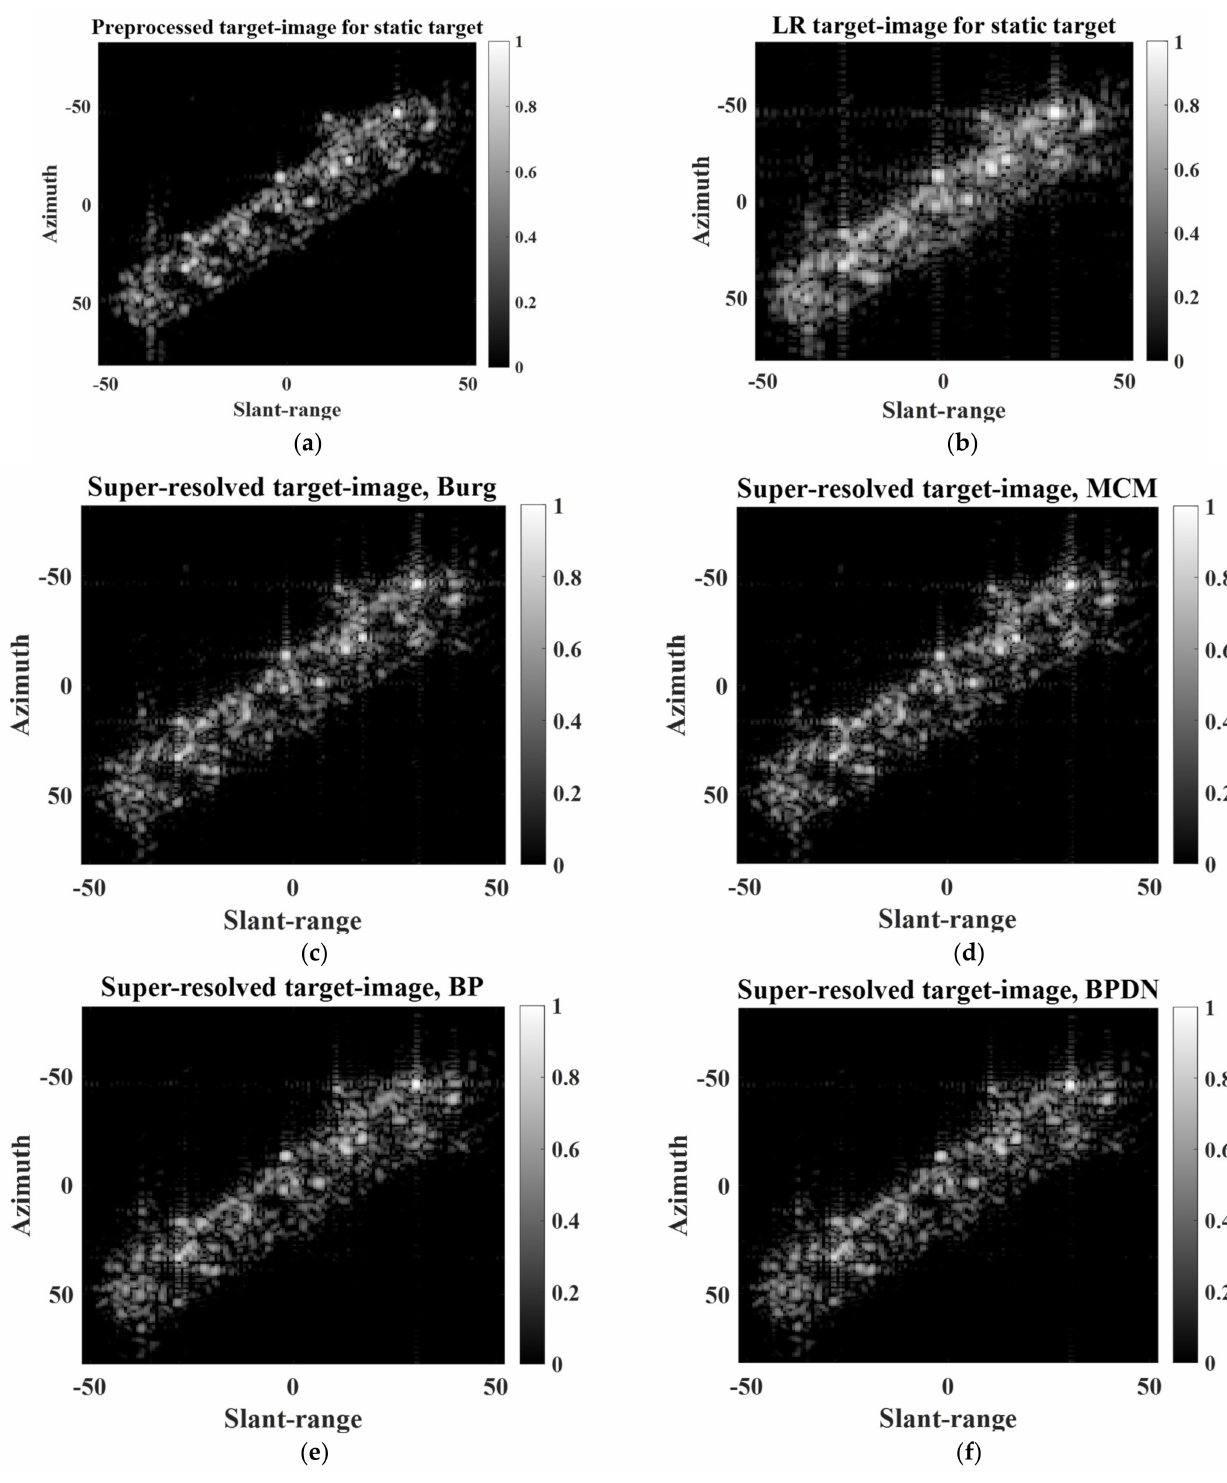
Figure 9. PR, LR, and super-resolved target images of extended static target: ( a ) PR, ( b ) LR, ( c ) Burg, ( d ) MCM, ( e ) BP, ( f )